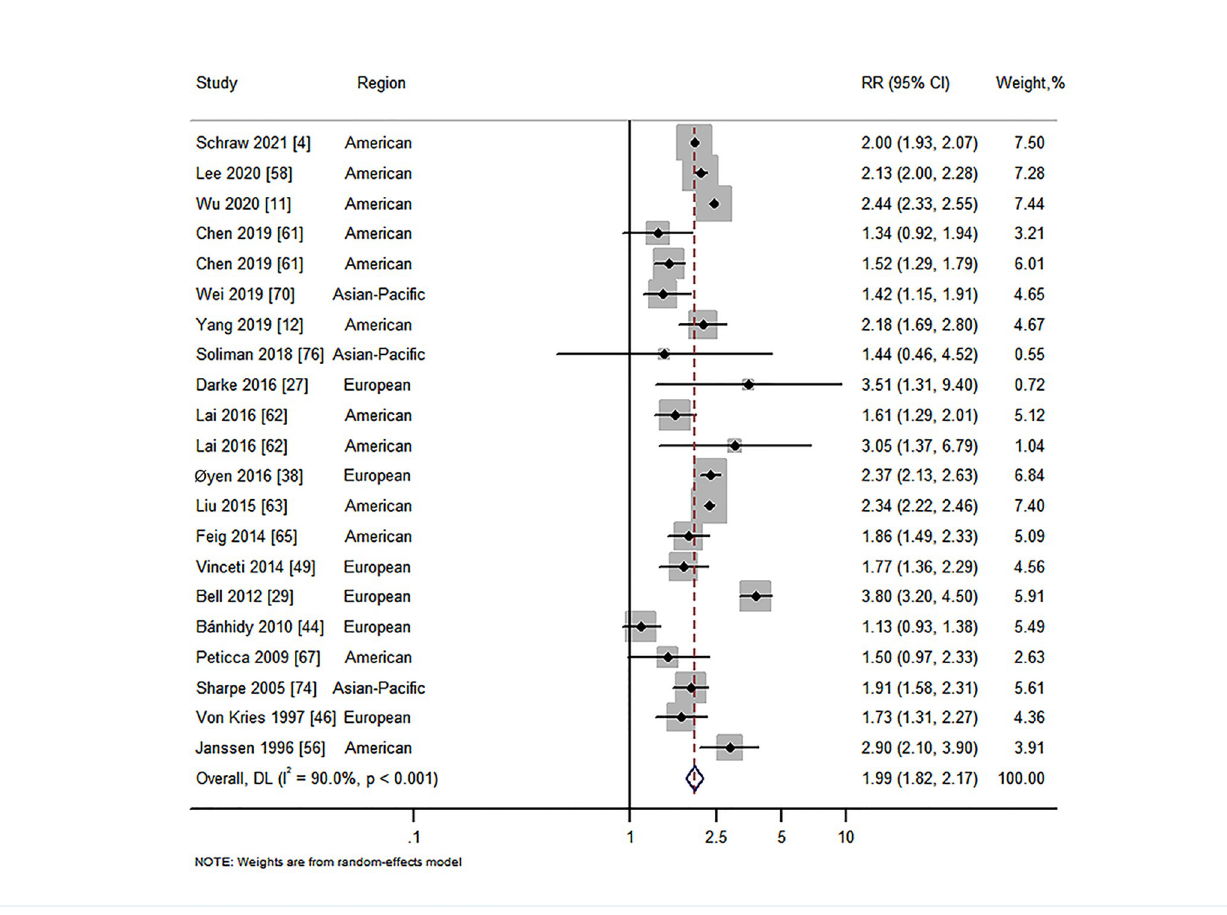
Fig 2. Forest plot of the RRs in population-based studies formaternal pre-gestational diabetes and the risk of overall congenital anomalies (RR = 1.99, 95% CI 1.82 to 2.17, I 2 = 90.0%, P < 0.001). Analytical weights are from random effects meta-analysis. Grey boxes represent study estimates; their size is proportional to the respective analytical weight. Lines through the boxes represent the 95% CIs around the study estimates. The diamond represents the mean estimate and its 95% CI. The vertical red dashed line indicates the mean estimate. CI, confidence interval; DL, DerSimonian and Laird random effects model; RR, relative